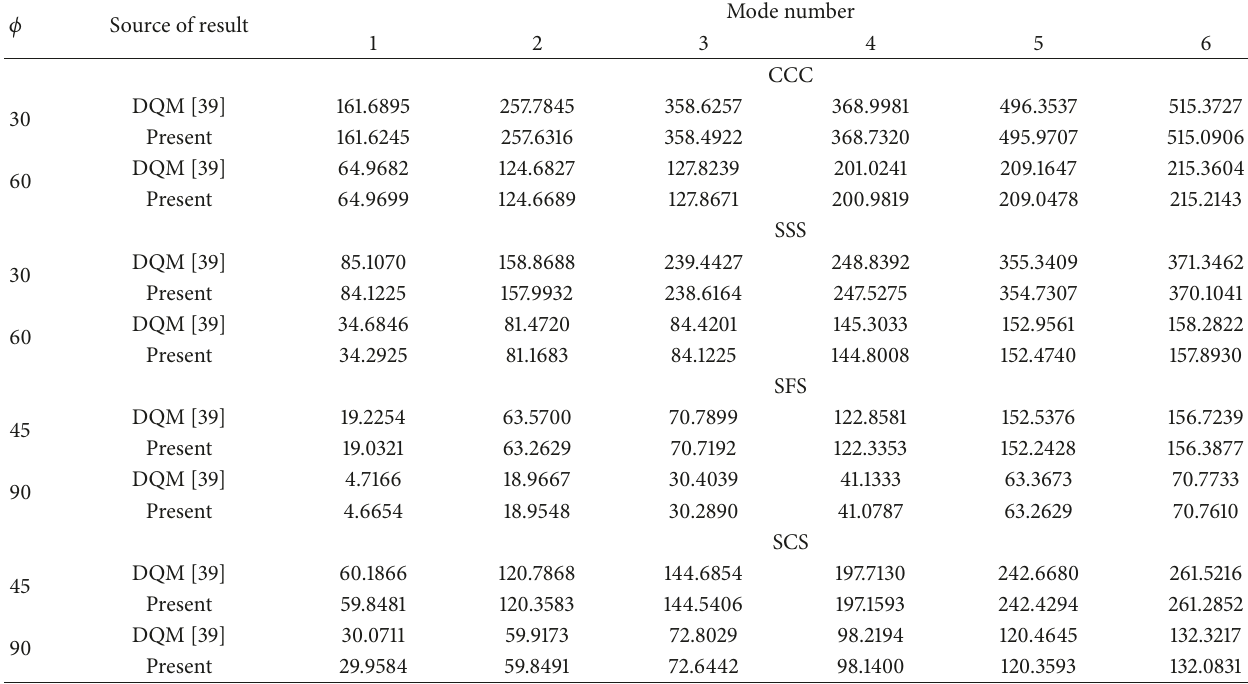
Table 4: Comparison of frequency parameters Ω = 𝜔𝑏 2 ( 𝐼 0 /𝐷 𝑐 ) 1/2 for Type 1-1 (1-0-0) circular sector plate with different boundary conditions and some values of 𝑝 = 1 , 𝜙 , and ℎ/𝑅 1 =